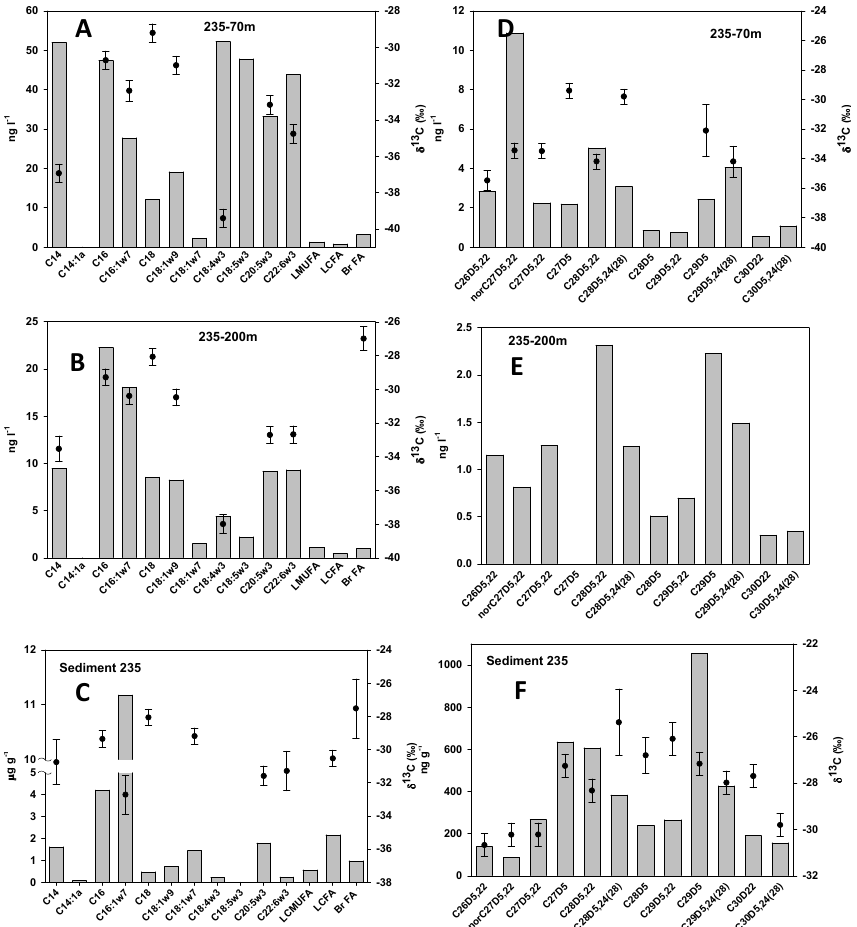
Fig. 9. Concentrations (bars) and carbon isotopic ratios (mean ± SD, n = 3) of selected fatty acids (A–C) and sterols (D–F) in a depth profile from site